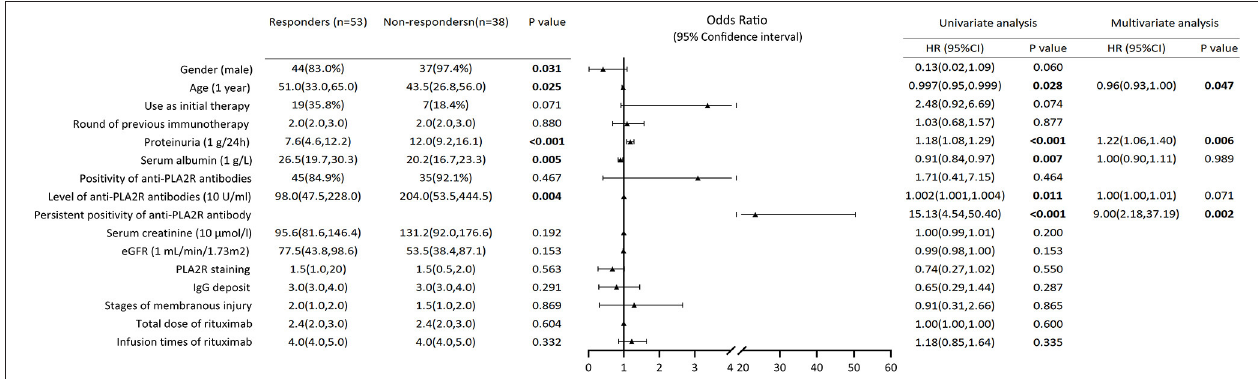
FIGURE 3 | Composite comparisons of clinical features of patients with pMN between responders and non-responders. Compared to the responders, the non-responders were more likely to be young man with higher levels of urinary protein, lower concentrations of serum albumin and higher levels of anti-PLA2R antibodies. The univariate logistic regression analysis showed that the higher level of urinary protein and the persistent positivity of anti-PLA2R antibodies were risk factors for not achieving remission after rituximab treatment. Multivariate logistic regression analysis showed that the higher level of urinary protein and the persistent positivity of anti-PLA2R antibodies were independent risk factors to rituximab treatment failure, while older age was an independent protective factor.